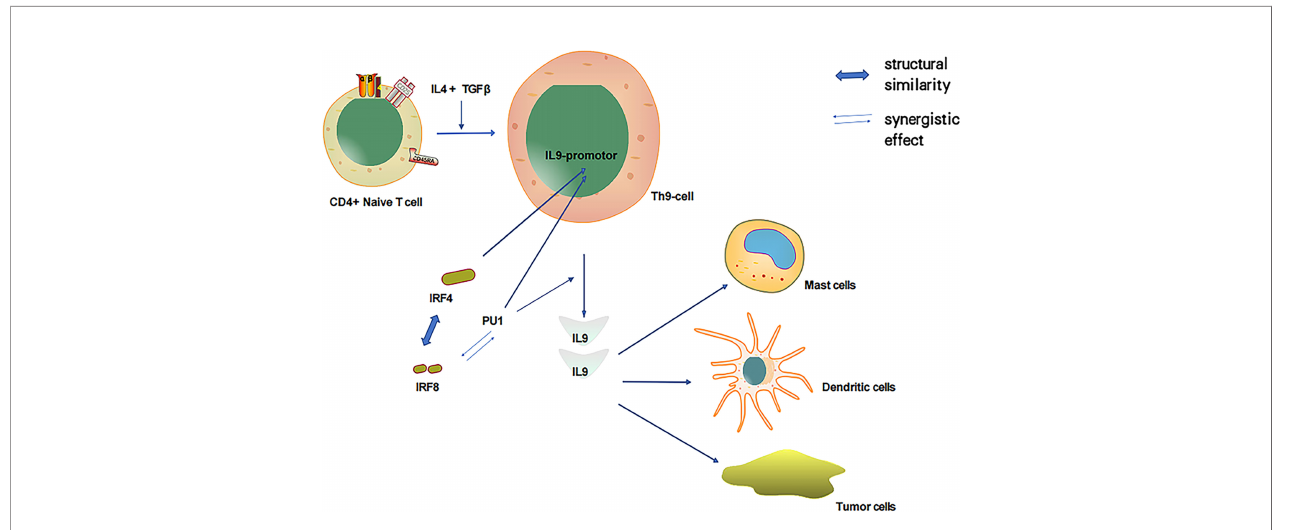
FIGURE 2 | IL-4 and TGF b induced T cells to produce IL-9 and relationship between important transcription factors PU1, IRF-4 and